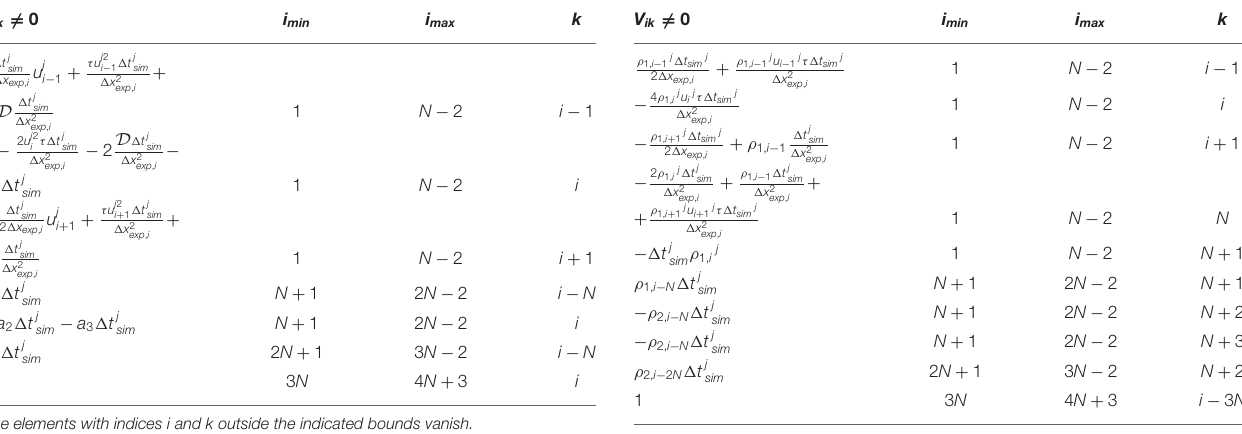
The elements with indices i and k outside the indicated bounds vanish.